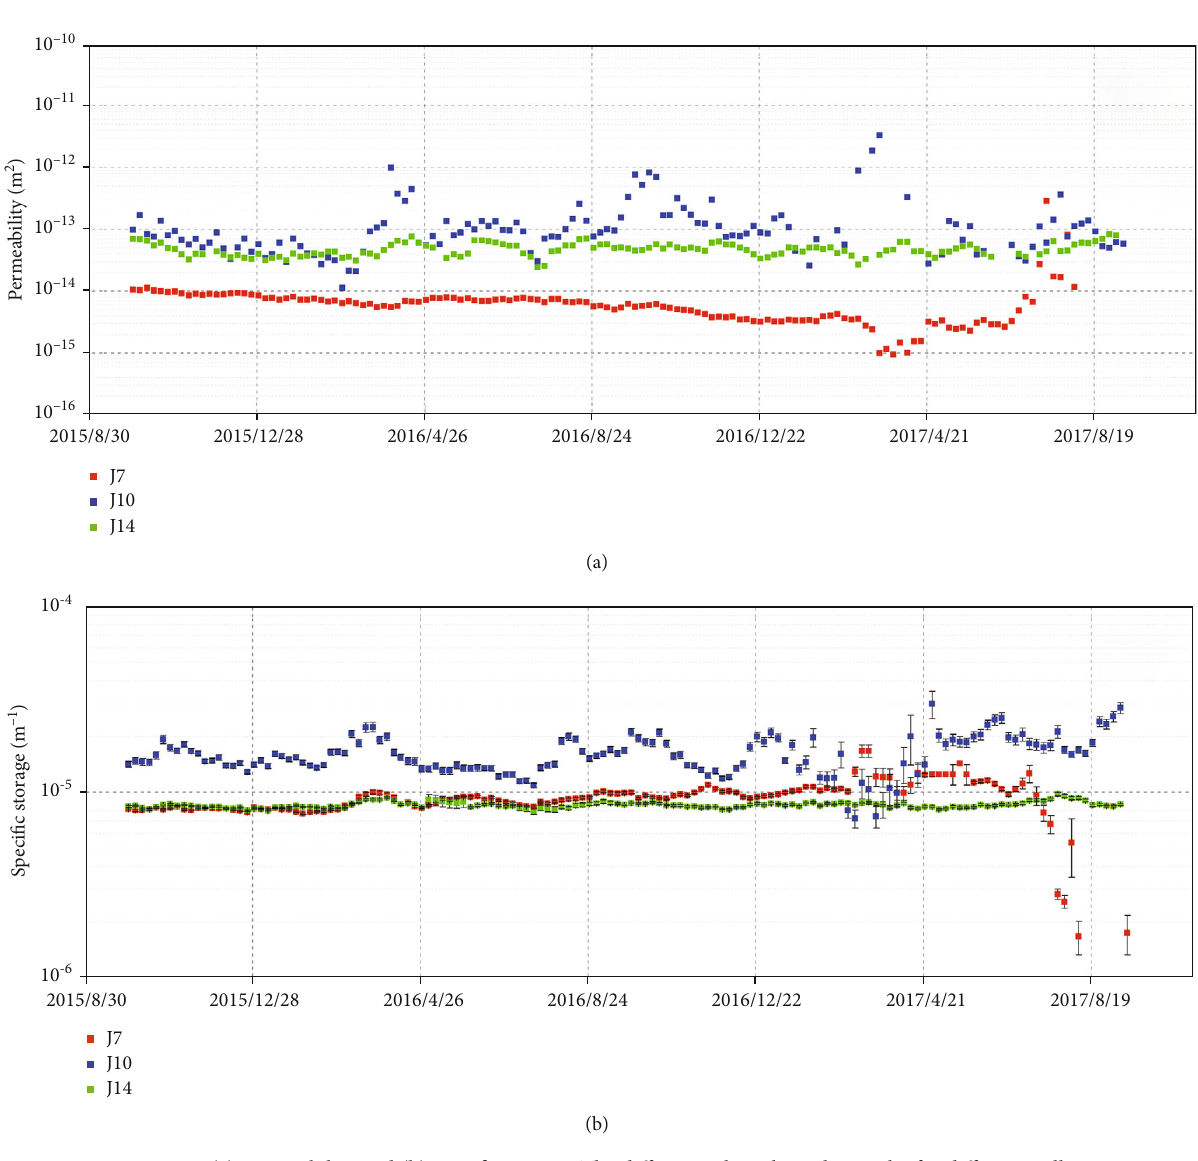
Figure 8: (a) Permeability and (b) speci fi c storage. The di ff erent colors show the results for di ff erent